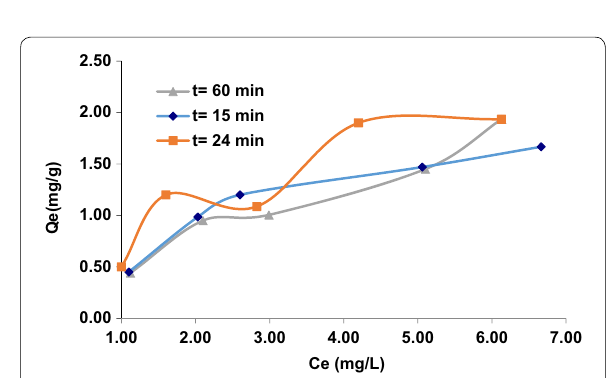
Fig. 8 Adsorption isotherms of arsenic (III) ion on the composite HAp/GA at t 15 min, t 24 min and t 60 = = =